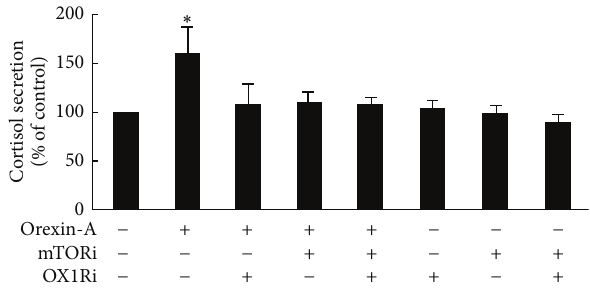
Figure 4: p70S6K/4EBP1 is involved in orexin-A causing cortisol secretion from H295R cells. Cells were exposed to orexin-A at concentration of 10 −6 M for 24h, in the presence of PF-04691502 (10 −6 M), SB674042 (10 −6 M), or the combination of both. Cortisol content was assessed using an ELISA kit. Data are presented as mean ± SEM of three independent experiments. Asterisks indicate significant differences compared to control ( ∗ 𝑃 < 0.05